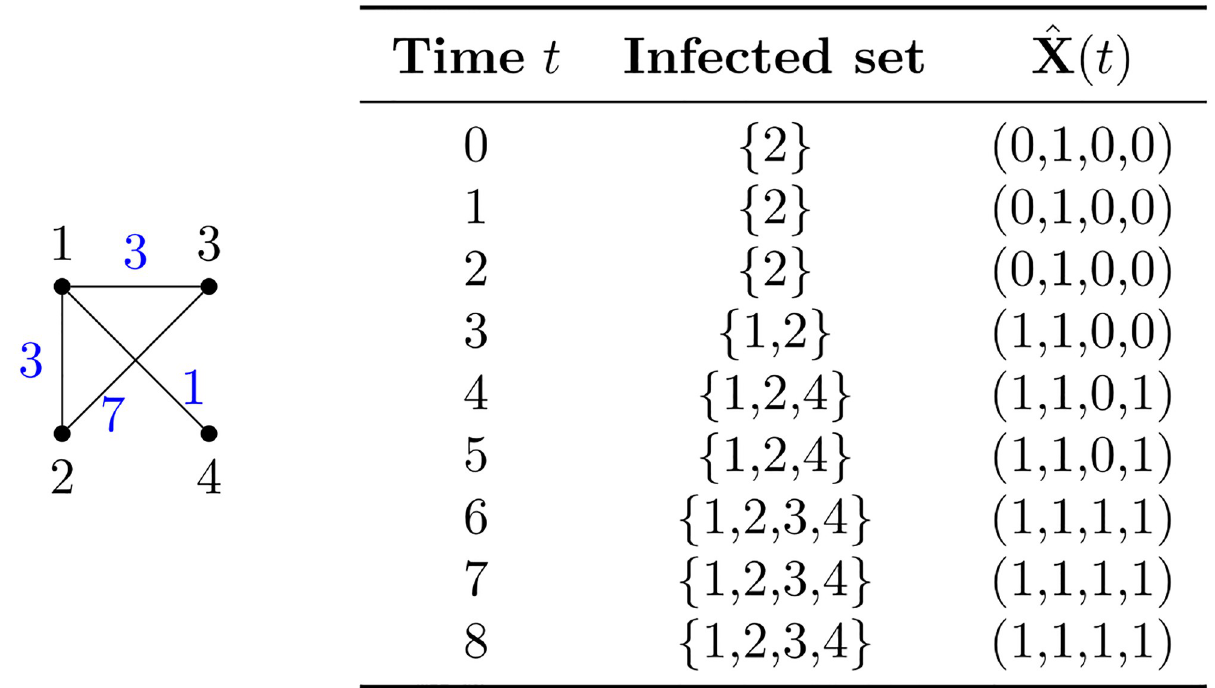
Fig 5. An example of the process ^ X ð t Þ . A random choice of the potential infection times τ in our example graph, displayed in blue, and the resulting i , j infection dynamic starting from ^ X ð 0 Þ ¼ s . Node 1 gets infected at time 3, node 4 gets infected at time 3 + 1 = 4, and node 3 gets infected at time 3 2 + 3 = 6 via node 1. The infection does not spread across edge {2, 3}, since both endpoints are already infected at time 7 when the potential infection is due to